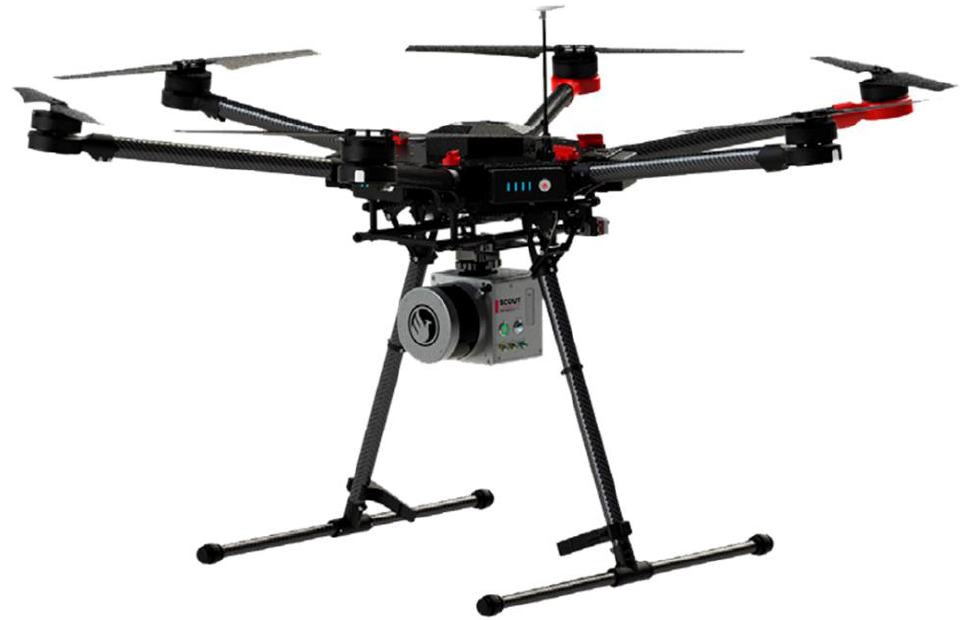
Figure 2. Scout Ultra LiDAR sensor on-board Phoenix drone platform. Table 2. Technical specifications of the self-generated drone LiDAR data.